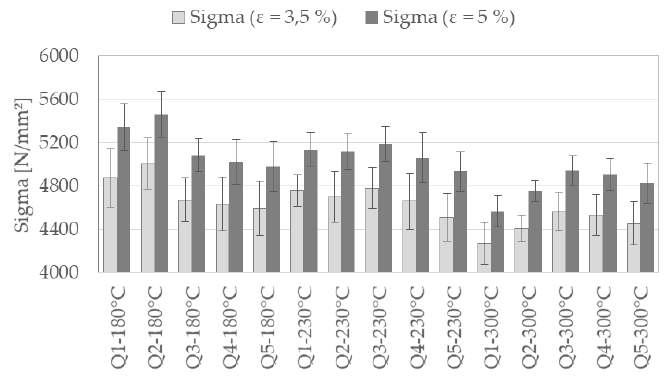
Figure 8. Stress descriptor, σ , at two di ff erent strains (3.5% and 5%) extracted from stress-strain relations of micro compression tests of the investigated heat treatment conditions of 100Cr6, ordered by annealing